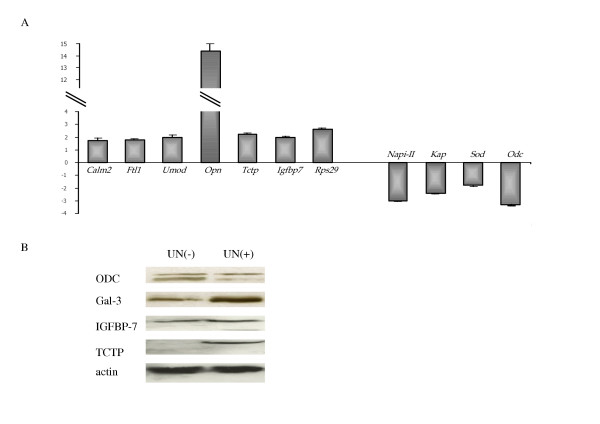
Confirmation of SAGE data. (A). Real-time RT-PCR analysis. The relative fold change of UN(+)/UN(-) is plotted. PCR analyses were performed on cDNA from UN(-) or UN(+) tissues. All values represent the mean ± SEM. *p < 0.05 vs control. (B). Western blot analysis of ODC, TCTP, IGFBP7 and Gal-3 proteins in UN(-) and UN(+) tissues. Fifty micrograms of total cell protein were loaded per lane on a 10% SDS-polyacrylamide gel, and ODC, TCTP, IGFBP7 and Gal-3 were detected by immunoblotting with antibodies against the respective proteins. As a control for proteins loading in SDS-PAGE, an anti-β-actin antibody was used.